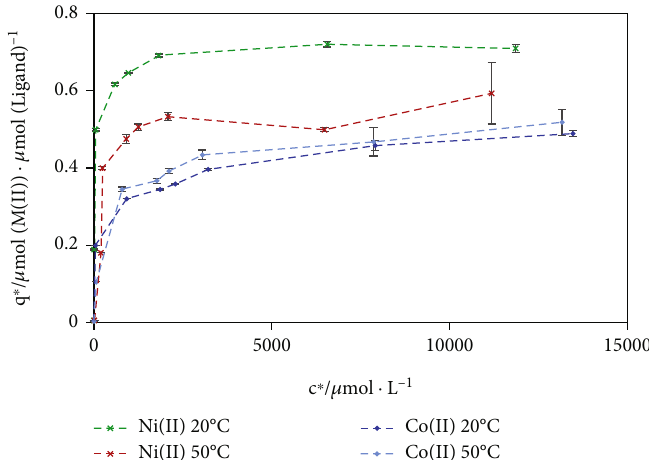
Figure 1: Adsorption isotherms for the single-component systems Ni(II), and Co(II) at T = 20 ° C and T = 50 ° C, respectively. Table 2: Characteristic Langmuir isotherm parameters ( K Adsorptive